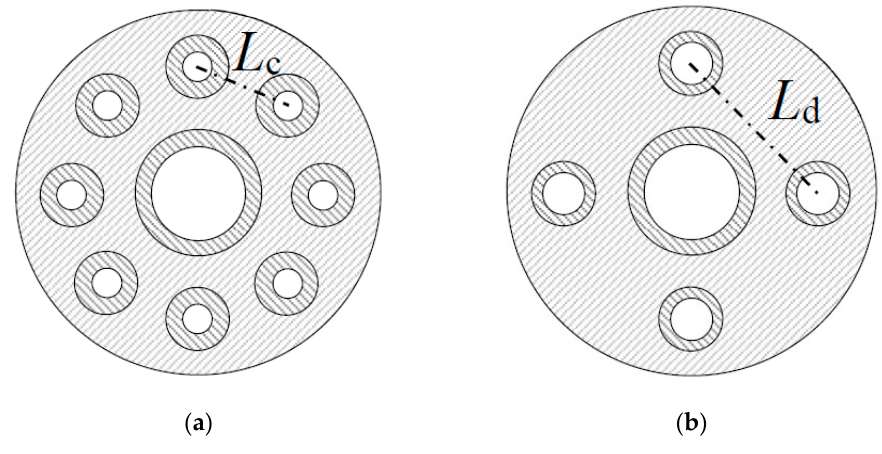
Figure 17. Nozzle layout of ( a ) φ 8.4 × 8; ( b ) φ 11.9 × 4.